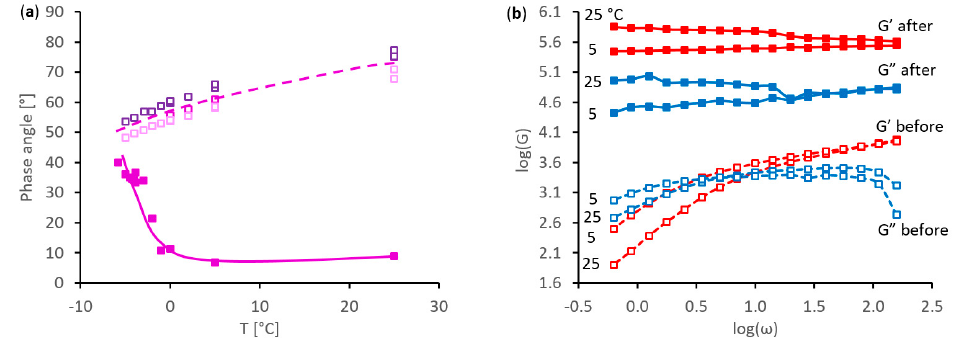
Figure 7. Rheological behaviour during gelation of a silk feedstock specimen due to freezing: ( a ) changes in phase angle (at 0.1 Hz) during cooling from 25 to − 6 °C and subsequent heating from − 6 to 25 °C; ( b ) comparison between oscillatory data measured at 25 and 5 °C, prior to (open symbols and dashed lines) and after (filled symbols and solid lines) the freezing cycle shown in ( a ). Different colours in ( a ) indicate different specimens; the open points show data prior to freezing, the filled points show data after freezing.